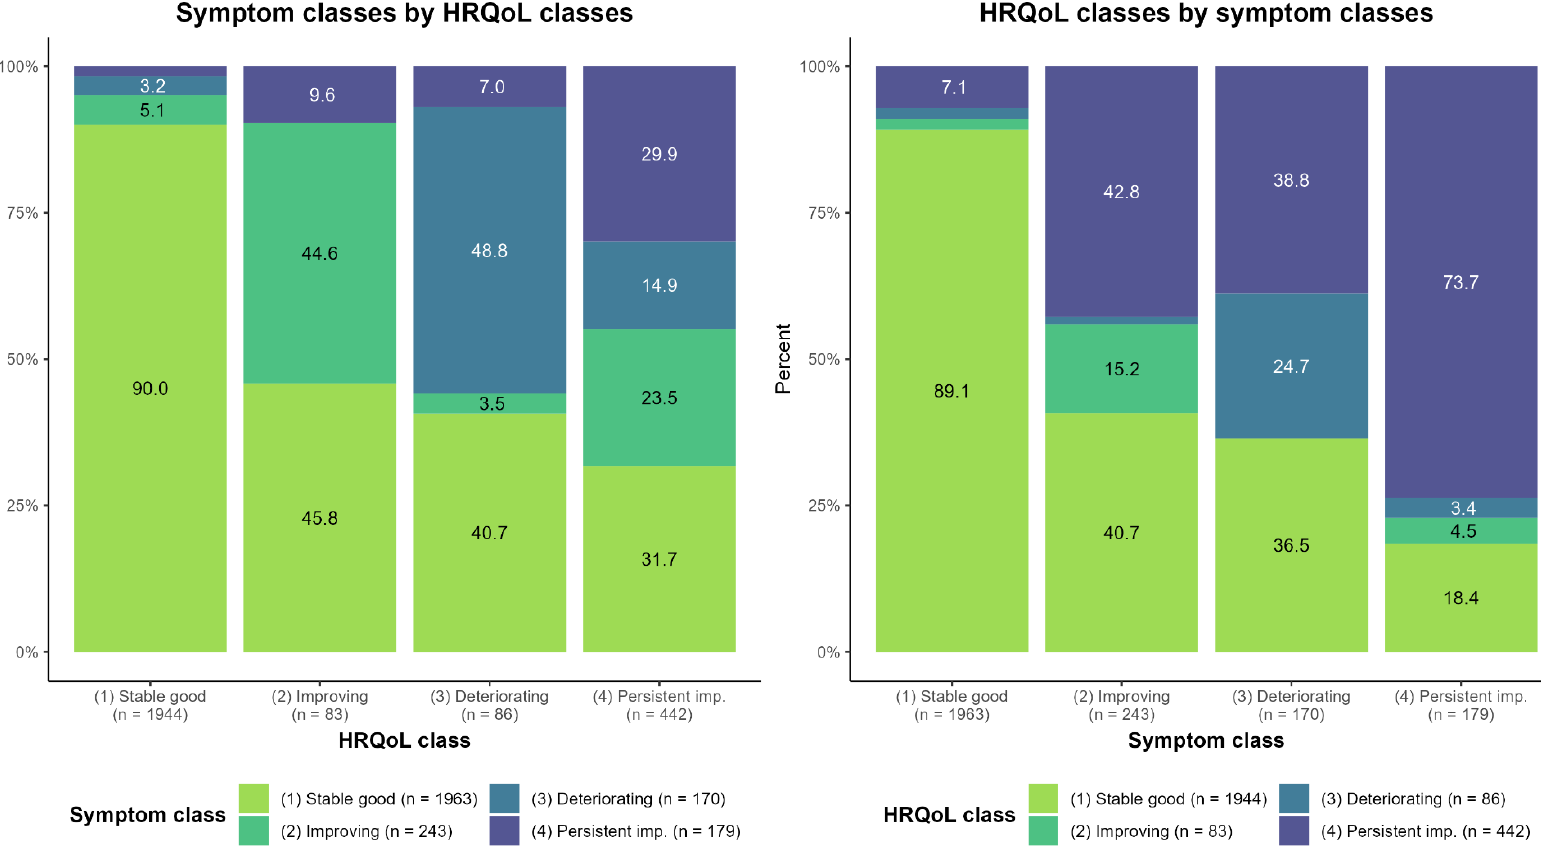
Figure A3. Association of HRQoL and symptom classes identified by Multivariate Latent Class Mixture Modelling ( χ 2(9) = 1152.96, p < 0.001; Cramer’s v = 0.39 [small: 0.1, medium: 0.2, large: 0.6]); percentages < 3% not displayed.